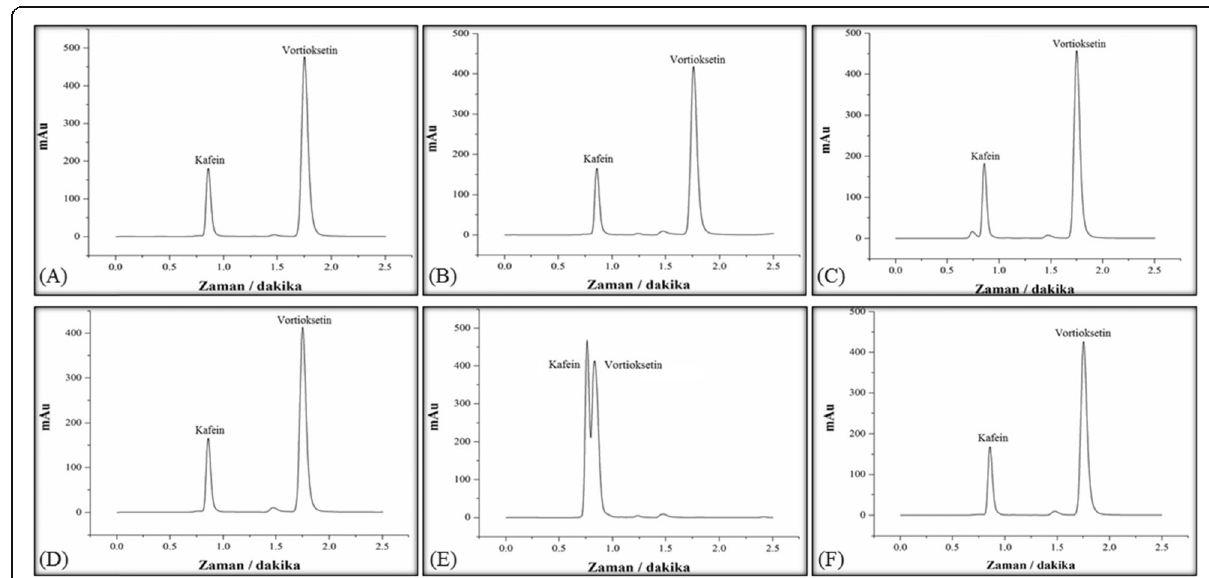
Fig. 3 Chromatograms of VRT and CAF in mixture ( b : acid, c : base, d : thermal, e : oxidation, f : photolytic) ( a : non-degradation)